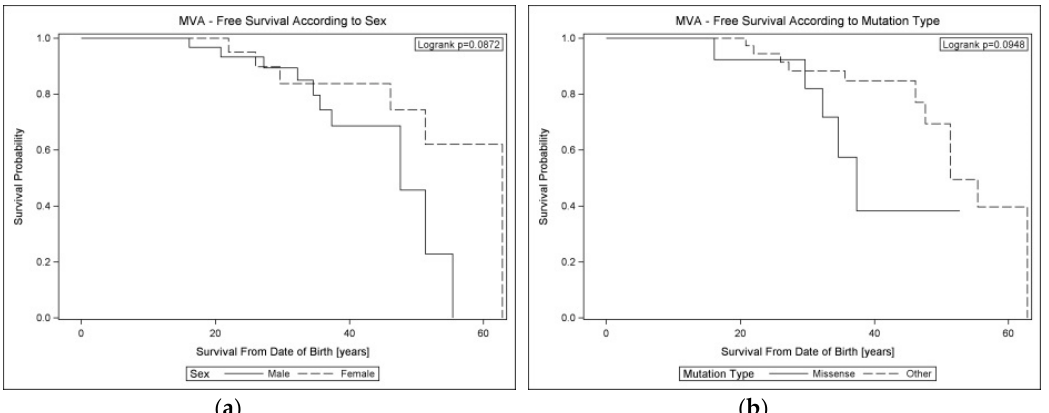
Figure 5. Kaplan–Meier lifelong MVA-free survival curves in cardiolaminopathy according to ( a ) sex and ( b ) mutation type. Legend: MVA: malignant ventricular arrhythmia.